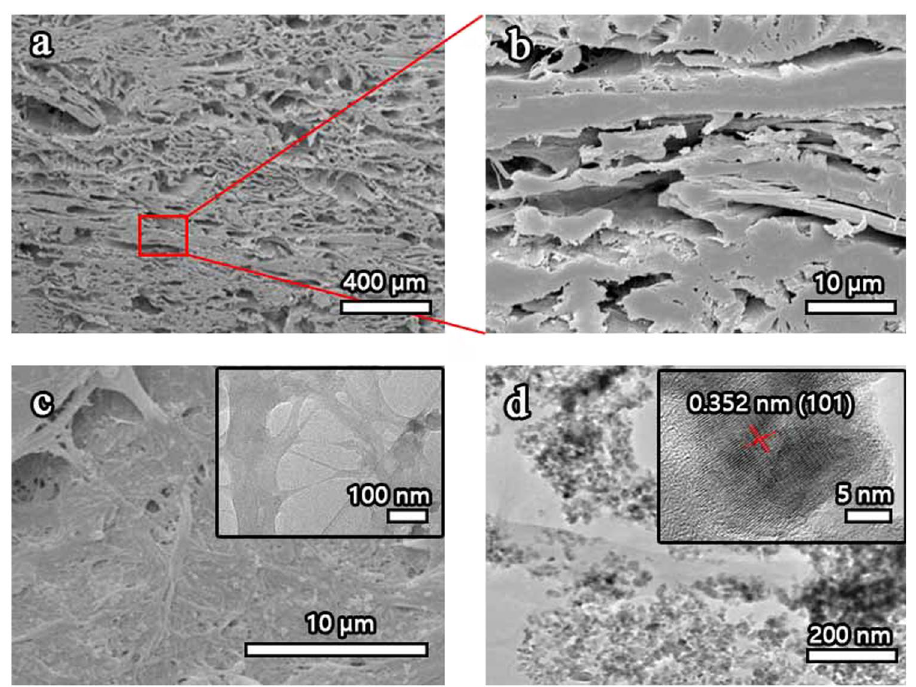
Figure 2. ( a ) Cross-sectional SEM image of NCL/PVA/TiO 2 composite, showing its many layered structure. ( b ) Magnified image of one layer of ( a ). ( c ) Magnified top view of NCL/PVA/TiO 2 composite, the inset is the HRTEM image of pure NLC. ( d ) TEM images for NCL/PVA/TiO 2 composite, the inset is the HRTEM image of TiO 2